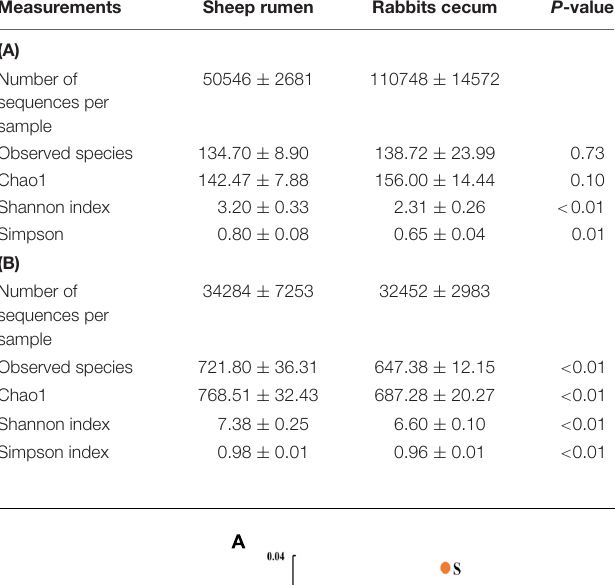
TABLE 4 | Alpha diversity measurements of archaeal (A) and bacterial (B) microbiota of the sheep rumen ( n = 5) and the rabbit cecum ( n = 5 blocks). Measurements